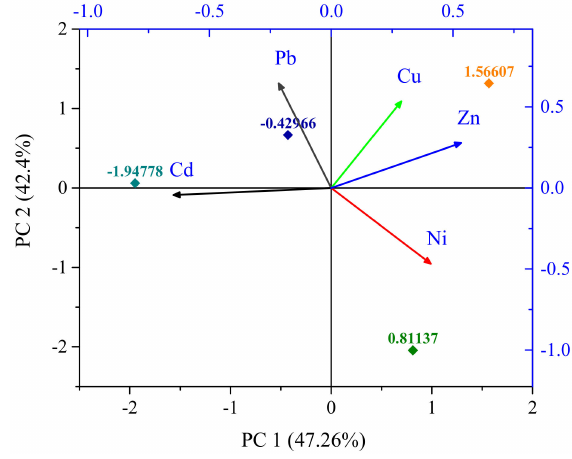
Figure 3. Loadings of PCA of the studied metals in samples.